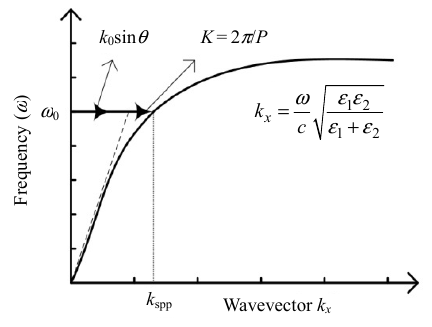
Fig. 2 Dispersion curve of SPPs.